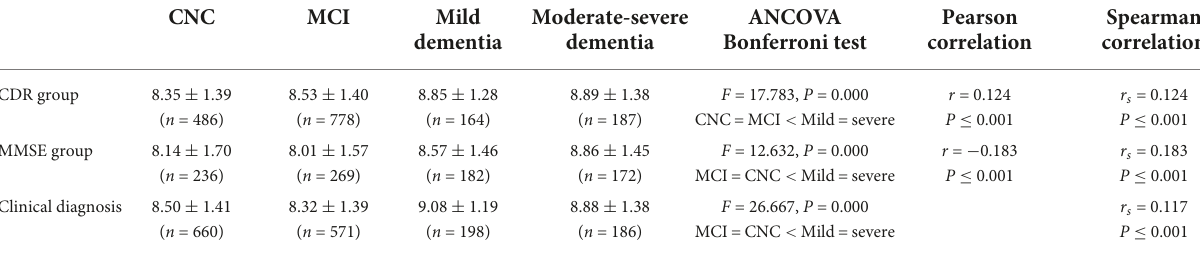
TABLE 3 Association between BDNF and cognitive